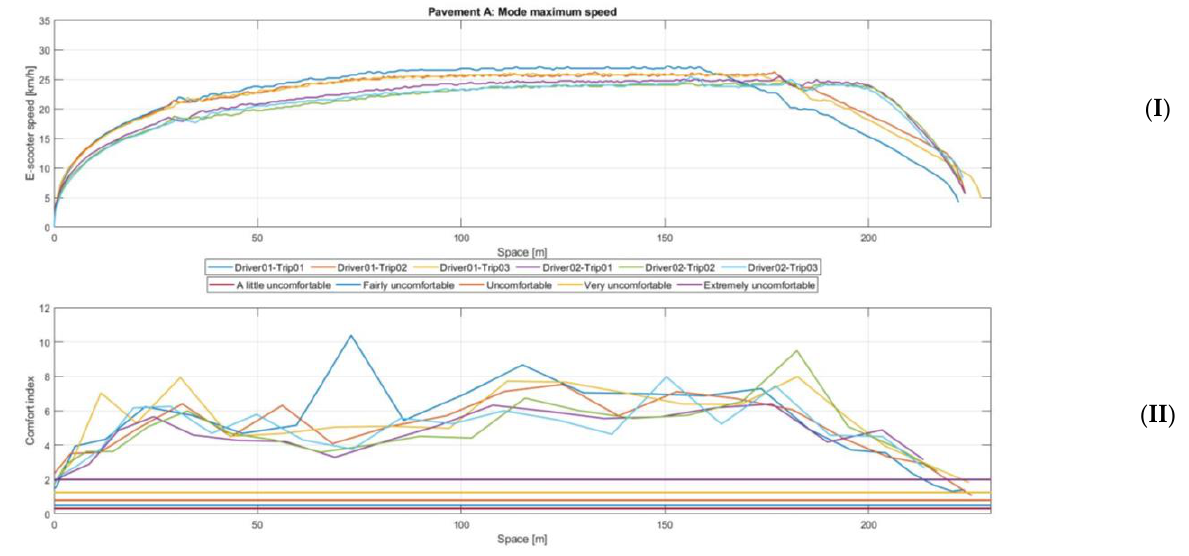
Figure 8. Speed profile ( I ) and comfort index ( II ) for 2 s RMS, pavement A, and mode MAX.